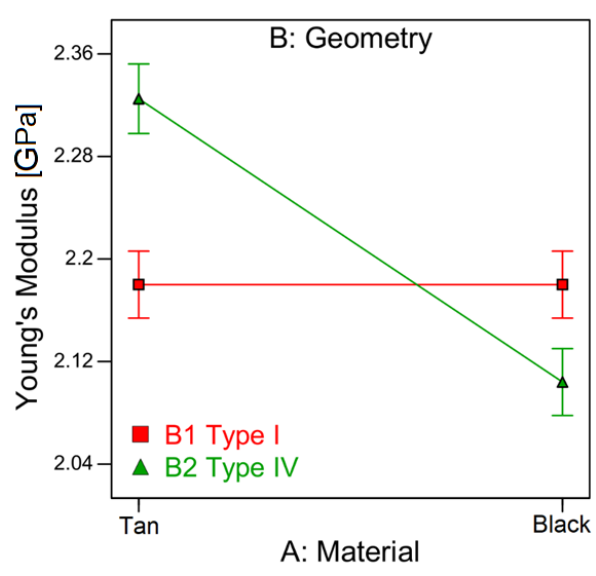
Figure 7. Normal probability plot for tensile test (Young’s modulus). Appl. Sci. 2020 , 10 , x FOR PEER REVIEW